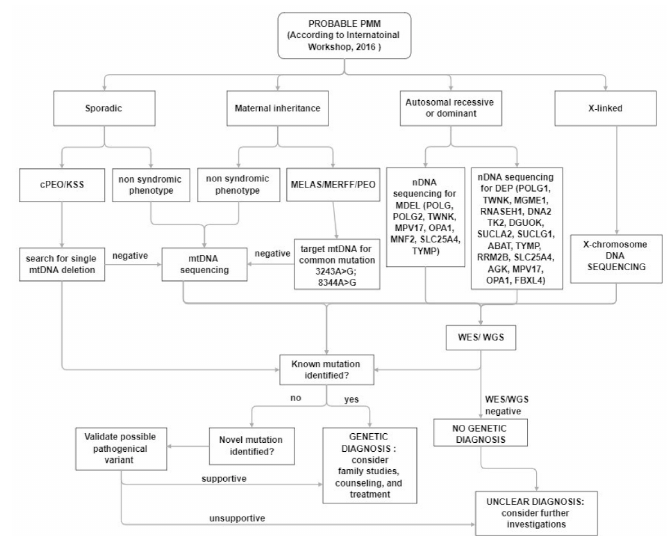
Figure 2. Diagnostic algorithm for patients with suspected